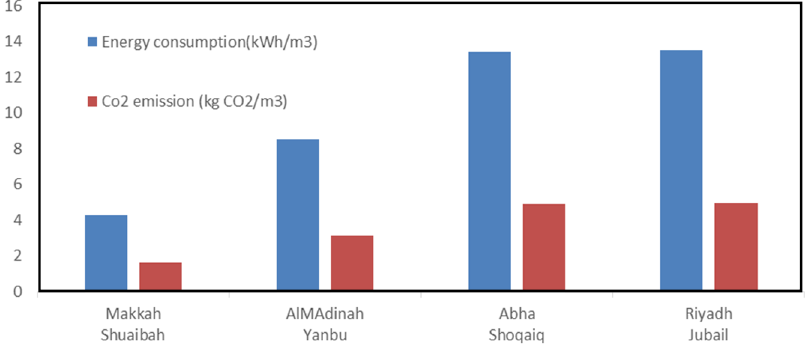
Figure 3. Energy consumption and emission of main pipelines in SA.